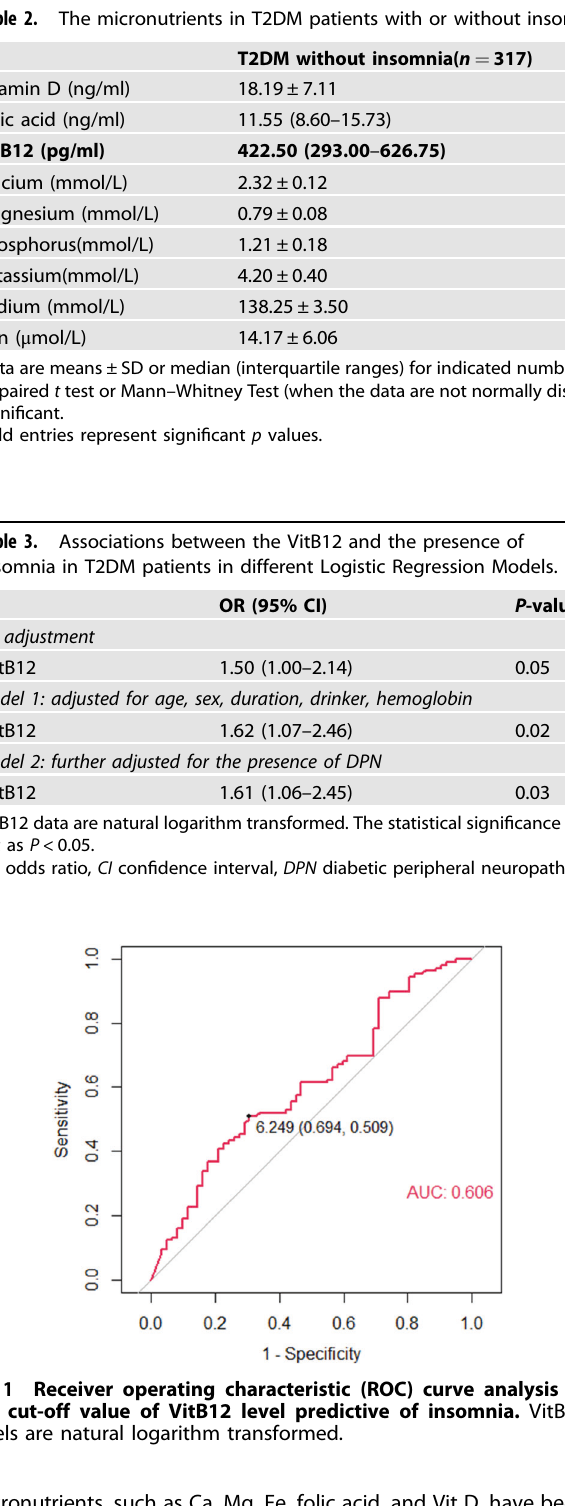
Table 2. The micronutrients in T2DM patients with or without insomnia.